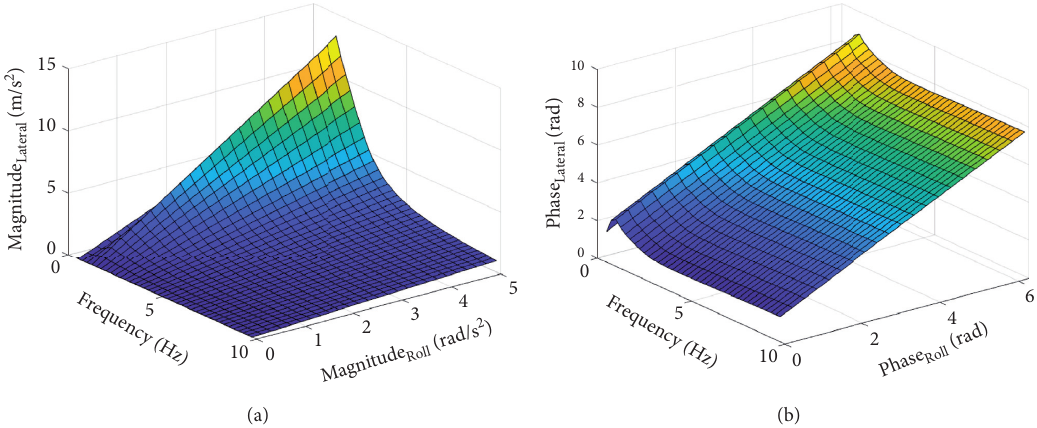
Figure 10: Equivalent surface of roll and lateral excitation in (a) magnitude and (b) phase.